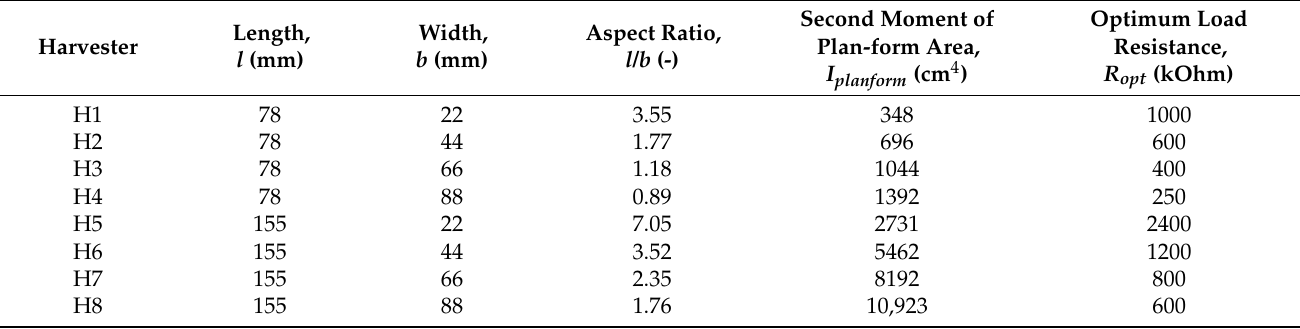
Table 1. Characteristics of the harvesters considered in this